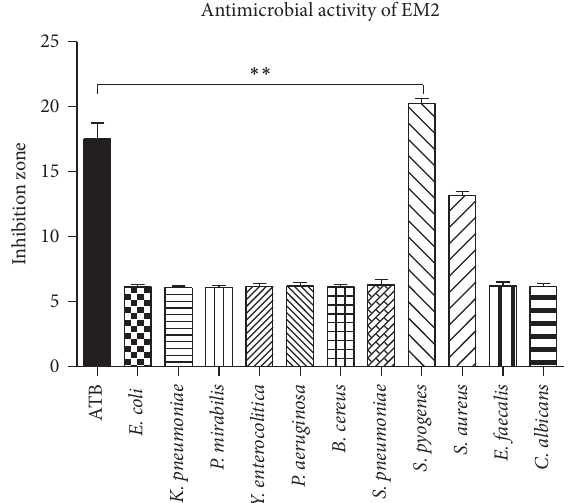
Figure 3: Zones of inhibition (mm) by EM2 for the mentioned bacterial strains and fungus. Data are presented as means ± SD. The experiments were carried out in duplicate ( 𝑃 < 0.01 versus the effects of antibiotics) . ∗∗ indicate 𝑃 < 0.01 as compared with the control